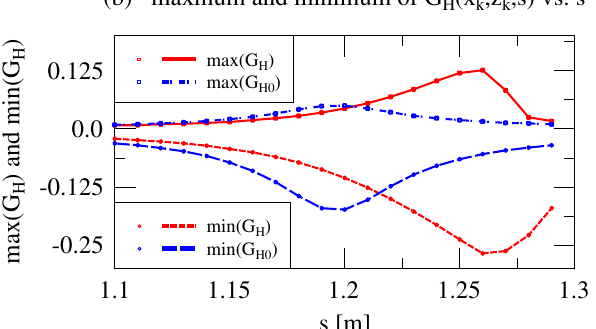
FIG. 7. (Color) Thin-bunch case: (cid:18) 10 (cid:4) 4 . (a) Mean of G tative particles; and (b) maximum and minimum values of (cid:3) ~ x ; ~ z ; s (cid:5) and G G H k k path length s .